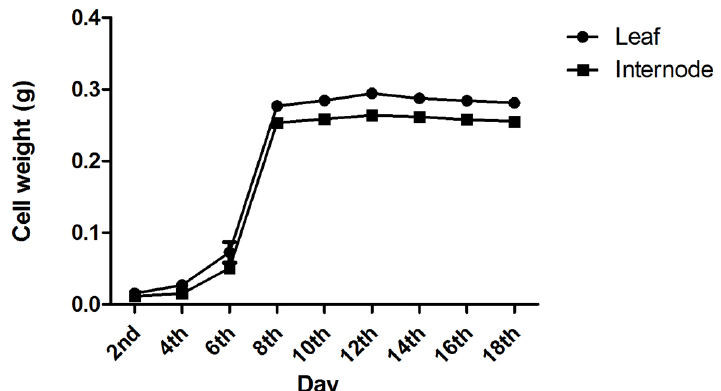
Fig. 2. Growth curve of cell growth at different time periods. There were three replications for each sample and the data was statistically significant